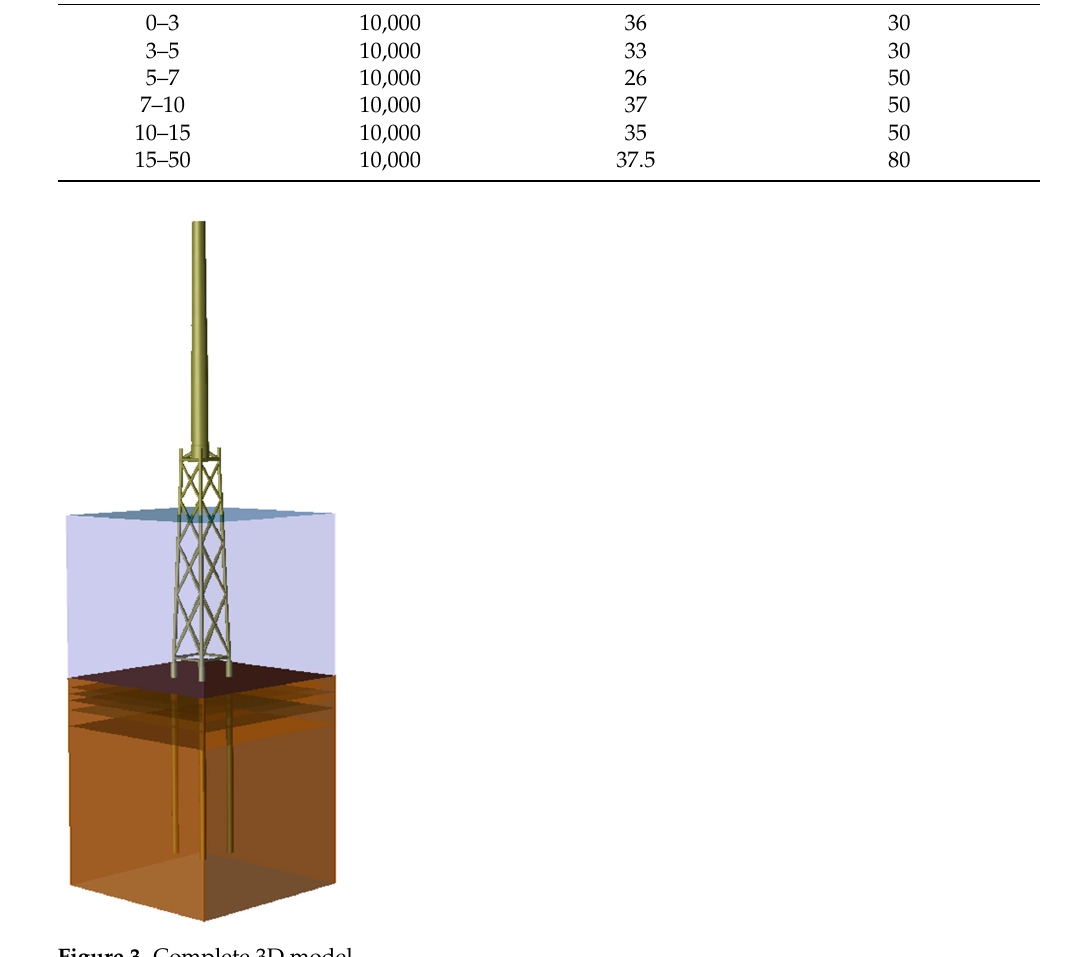
Figure 3. Complete 3D